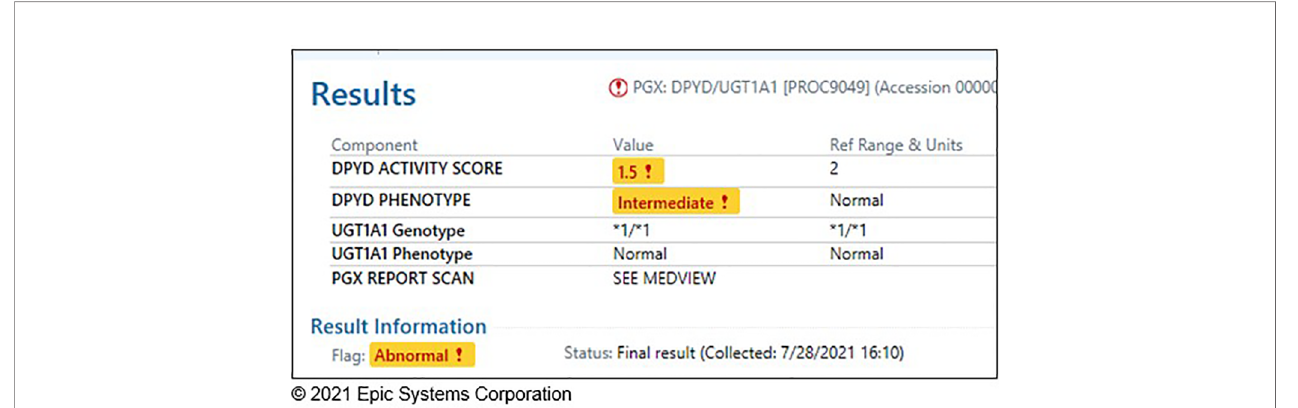
FIGURE 2 | Discrete DPYD / UGT1A1 genotype results in a patient